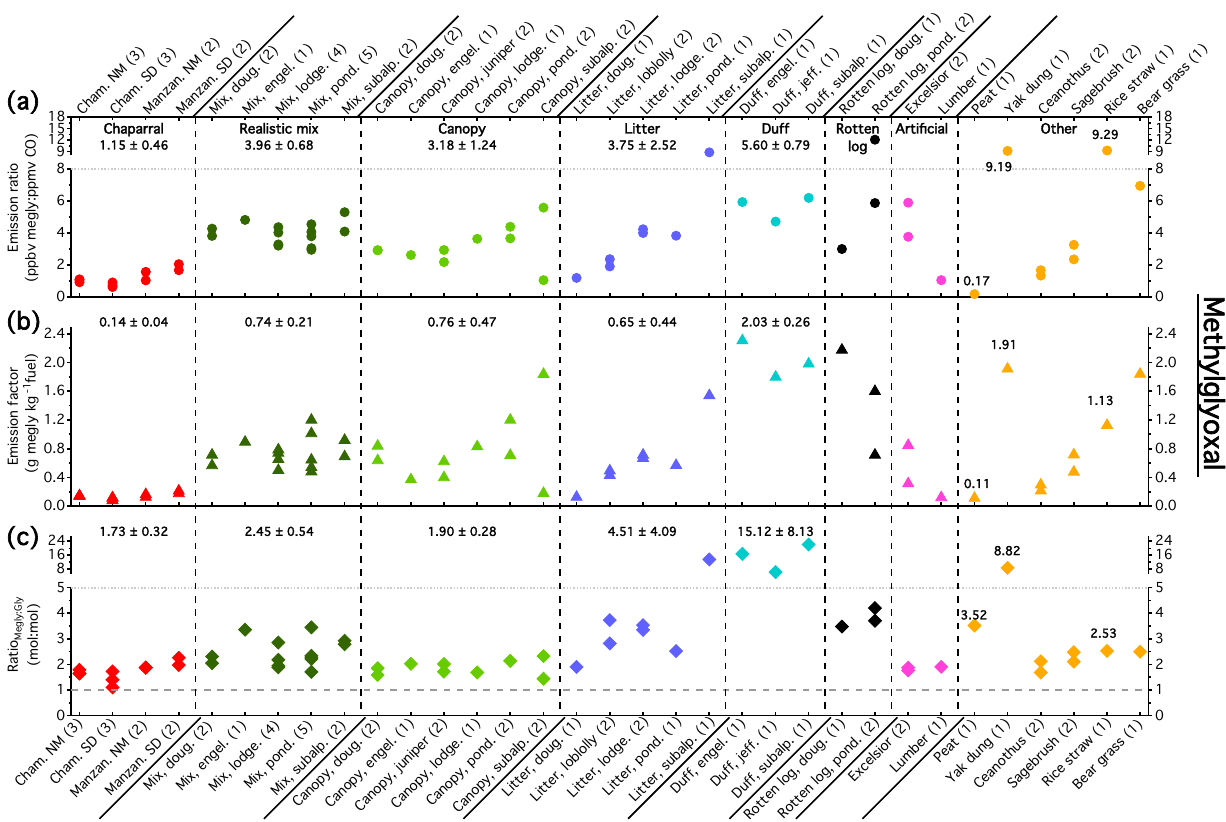
Figure 9. Methylglyoxal emission ratios (a) , emission factors (b) , and the molar ratio of methylglyoxal to glyoxal (c) . Note the split axes for the emission ratio and methylglyoxal to glyoxal plots. Average values for the first five fuel groups and values for certain individual fuels are also